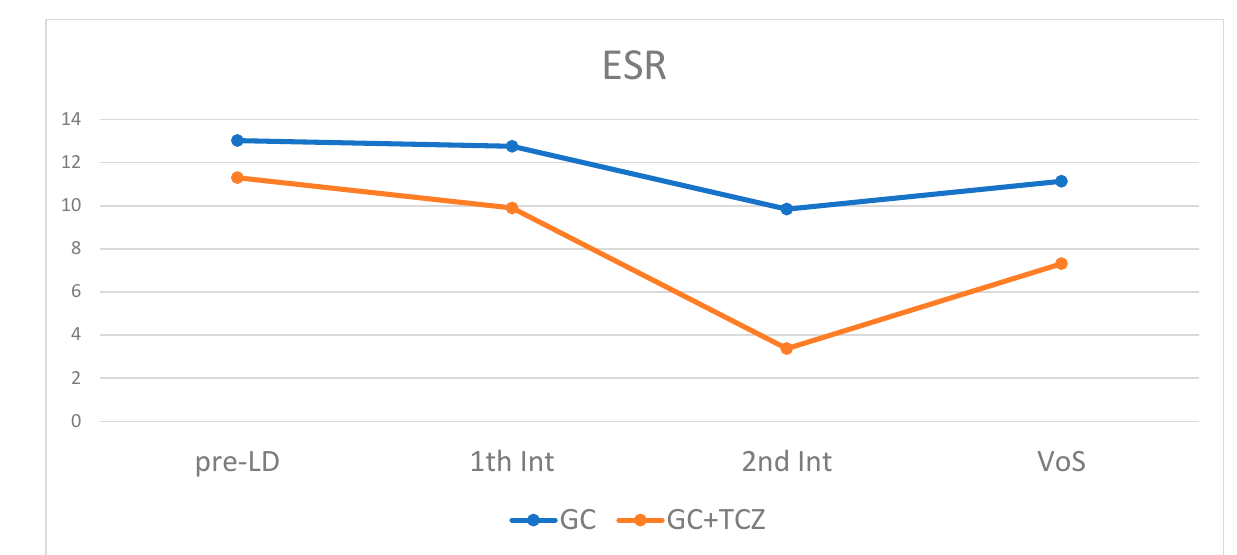
Figure 1. ESR trend during monitoring in the two di ff erent groups of patients treated with and